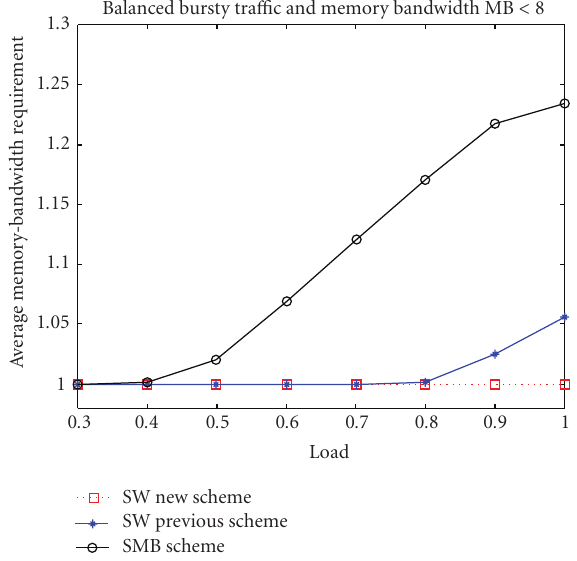
Figure 3: Average memory-bandwidth requirements of SW and SMB